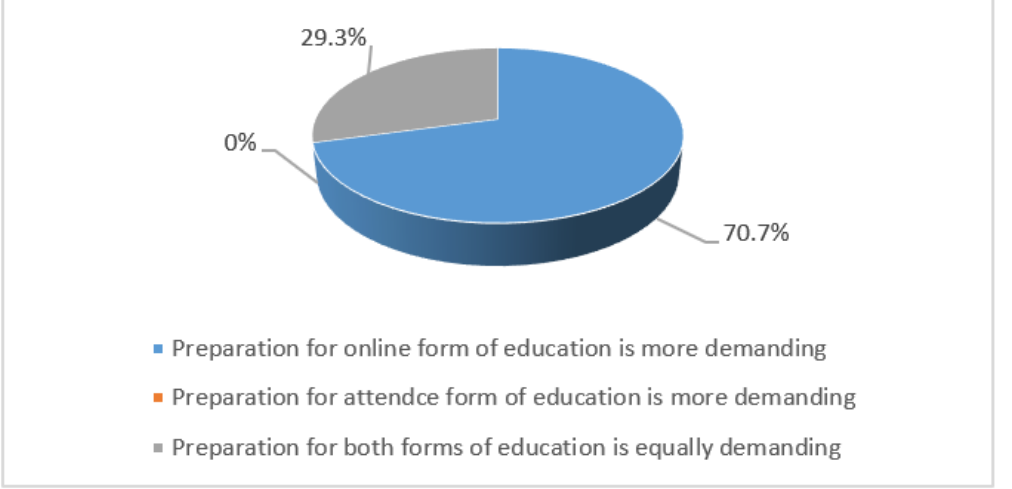
Figure 6. The response of teachers to the question: Which form of education do you consider more demanding for the